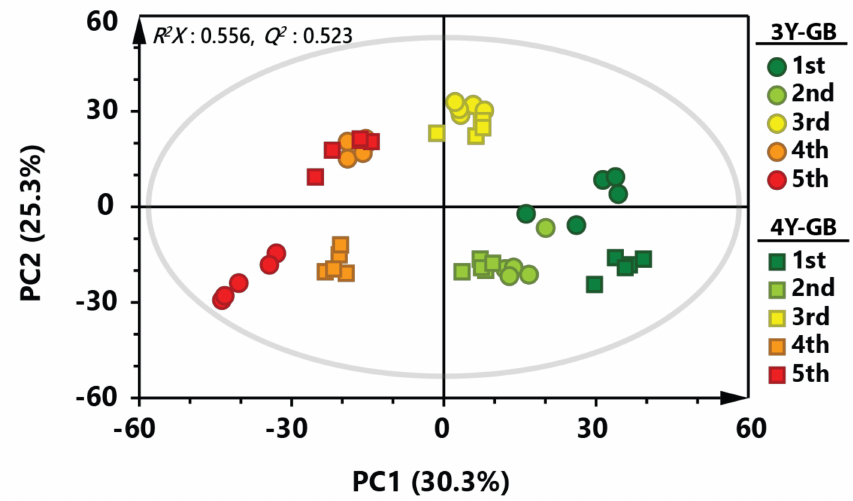
Figure 1. Principal component analysis (PCA) score plot derived from gas chromatography-mass spectrometry (GC-MS) data of GB at di ff erent ripening stages. Circular symbols and rectangular symbols represent three-year-old GB and four-year-old GB, respectively. The color of each symbol is as follows: green color, first harvested sample; light green, second harvested sample; yellow color, third-harvested sample; orange color, fourth-harvested sample; red color, fifth-harvested sample.